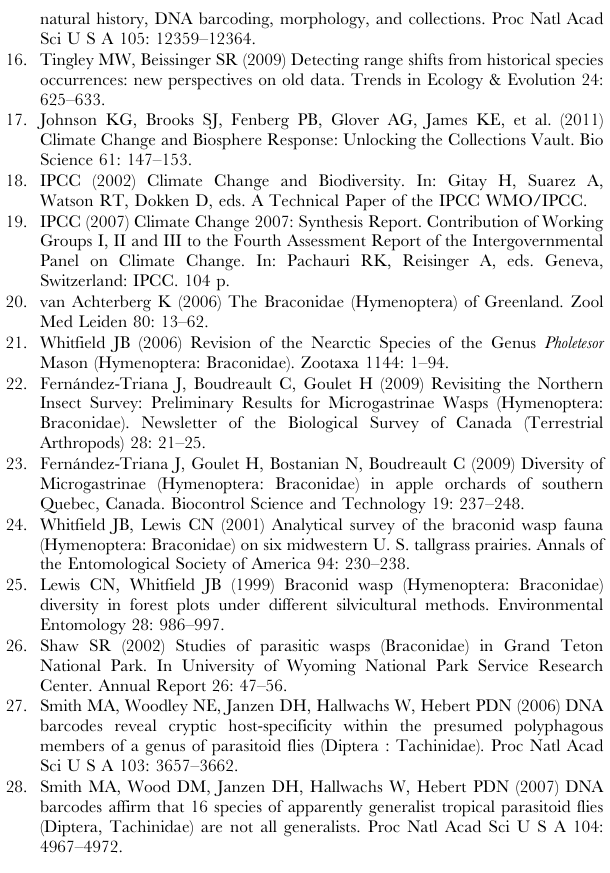
study. Table S2 Shannon-Wiener (H 9 ) and Evenness (J) diversity indices of Microgastrinae from Churchill, Manitoba, Canada.